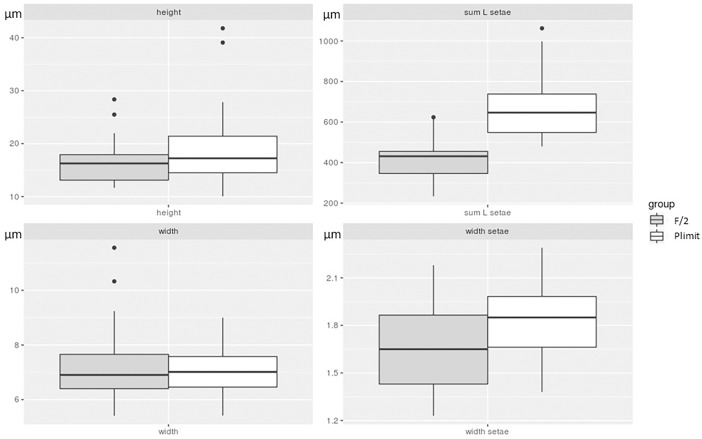
Morphology measurements.Box and whisker plots for the cell height (pervalvar axis), cell width (apical axis), sum lengths of all setae per cell and width of setae for C. peruvianus grown in F/2 (grey) and P-limit (white) medium. For both media 150 cells were measured.